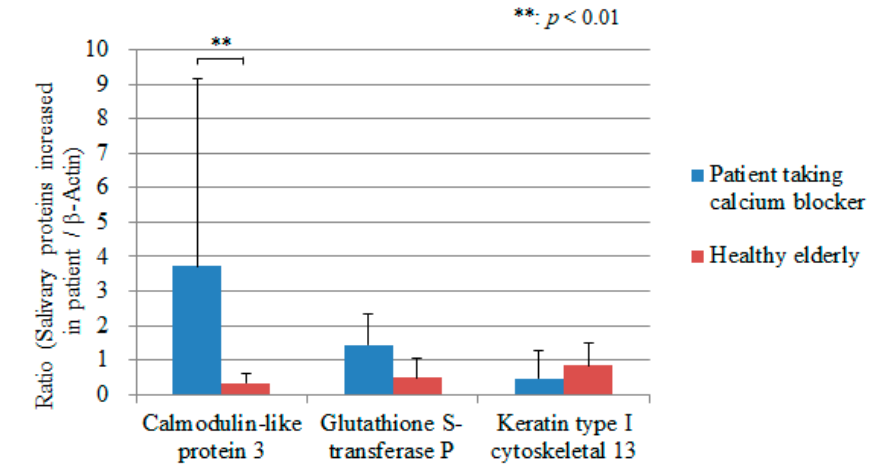
Figure 3. The expression of calmodulin-like protein 3, glutathione S-transferase P, and keratin type I cytoskeletal 13 divided by the value of β -Actin on the patient taking calcium blocker and healthy elderly. Measurements are expressed as mean value + SD. **: p < 0.01.